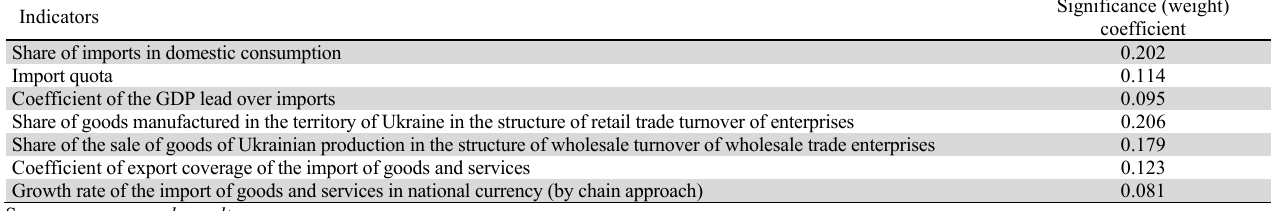
Weighted coefficients of the indicators of the integral index of the import dependency of Ukraine’s economy Indicators